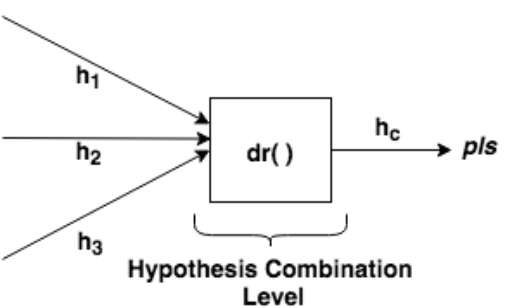
Figure 10. DST-CEP Hypothesis Combination Level (depicted from Figure